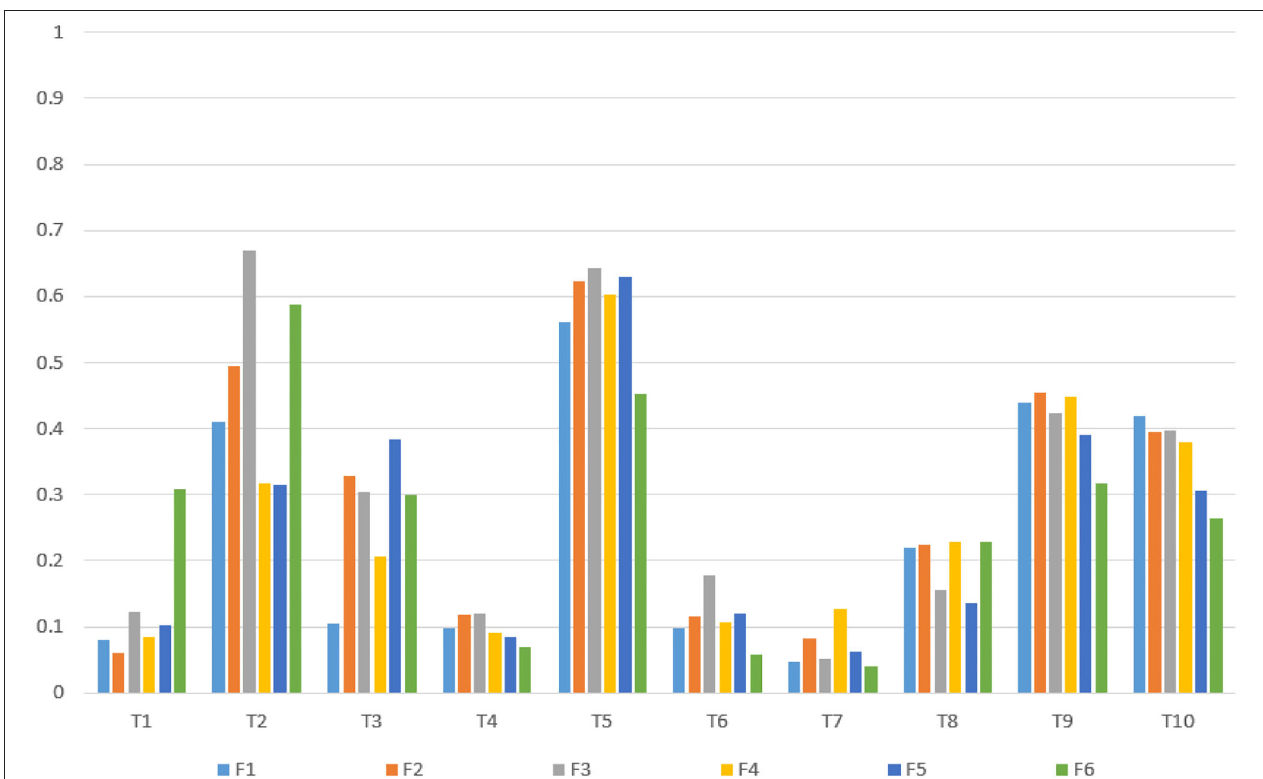
FIGURE 10 | PLV of fatigue sensitive channel P2 to frontal channels of 10 elderly